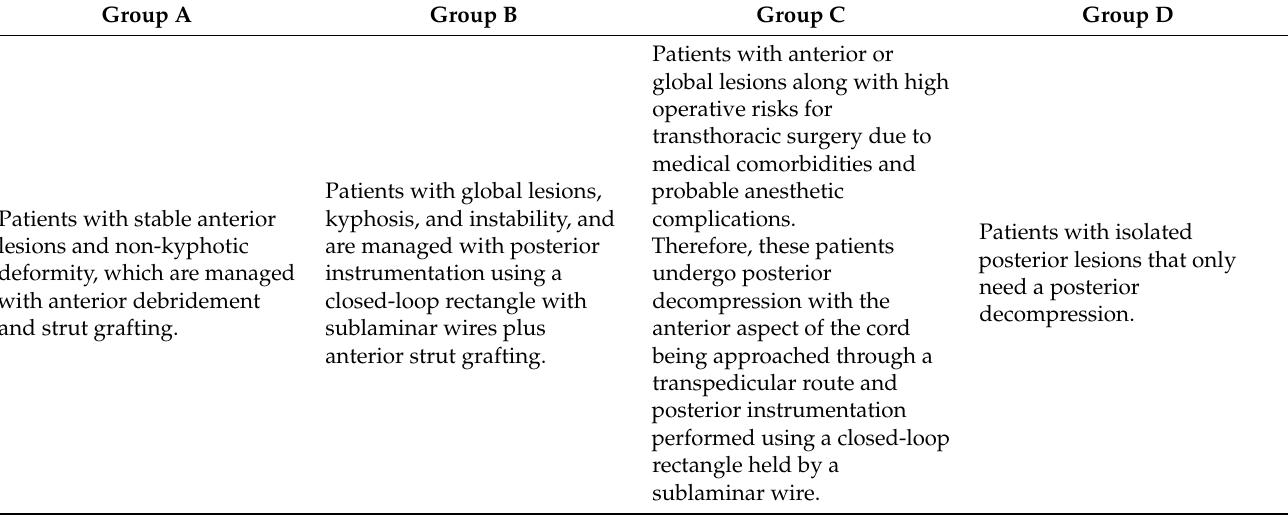
Table 3. Magnetic resonance imaging classification of spinal tuberculosis—Mehta and Bhojraj [53]. Group A Group B Group C Group D